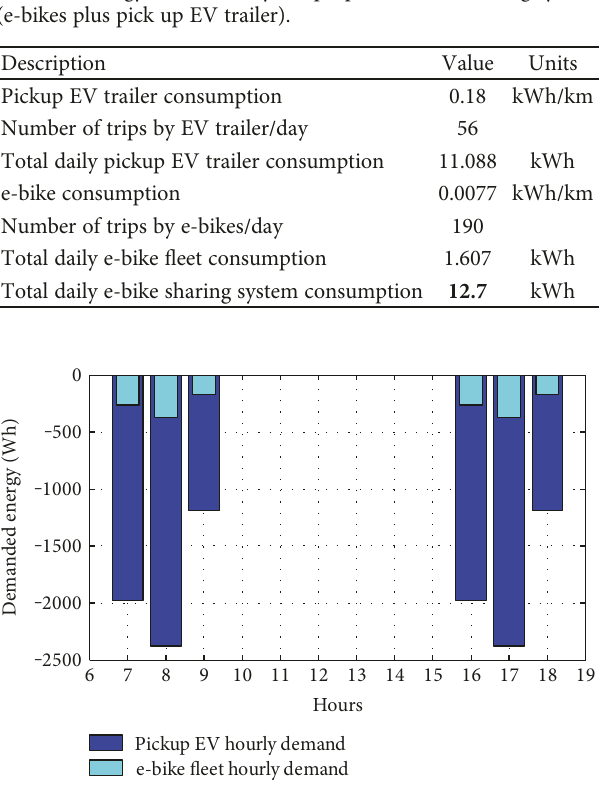
Figure 10: e-bike sharing system hourly energy consumption.